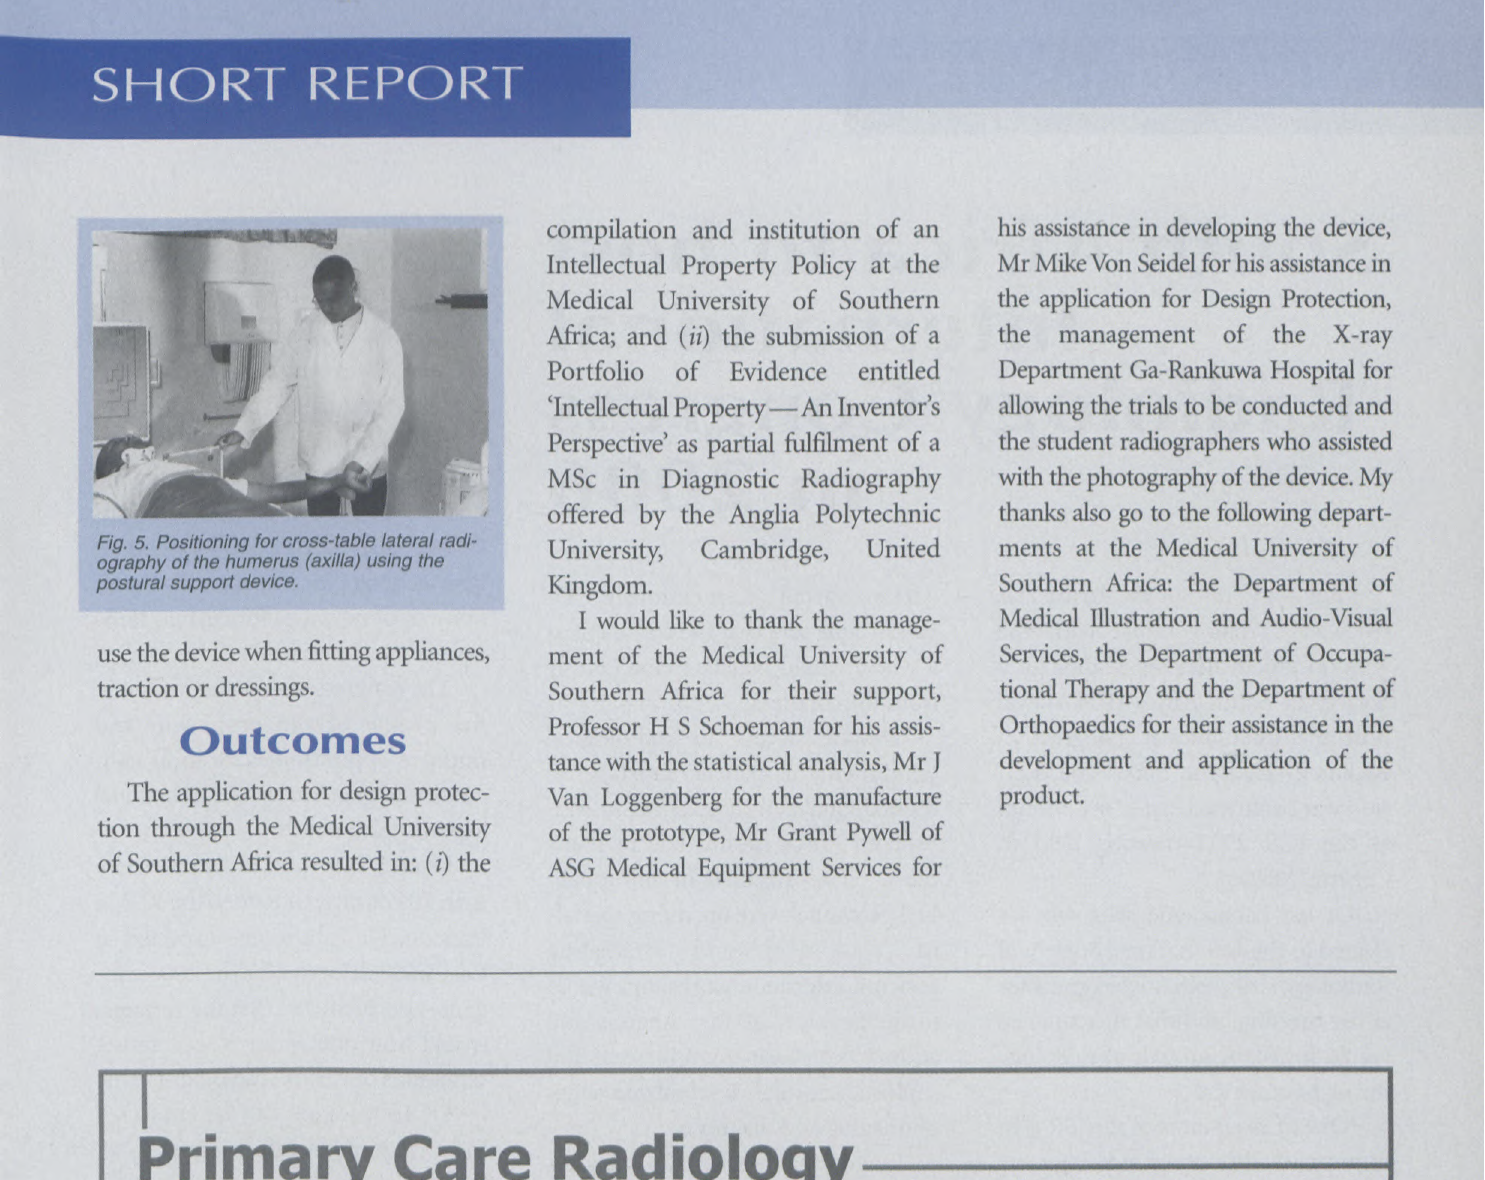
Fig. 5. Positioning for cross-table lateral radi- ography of the humerus (axilla) us/ng the postural support